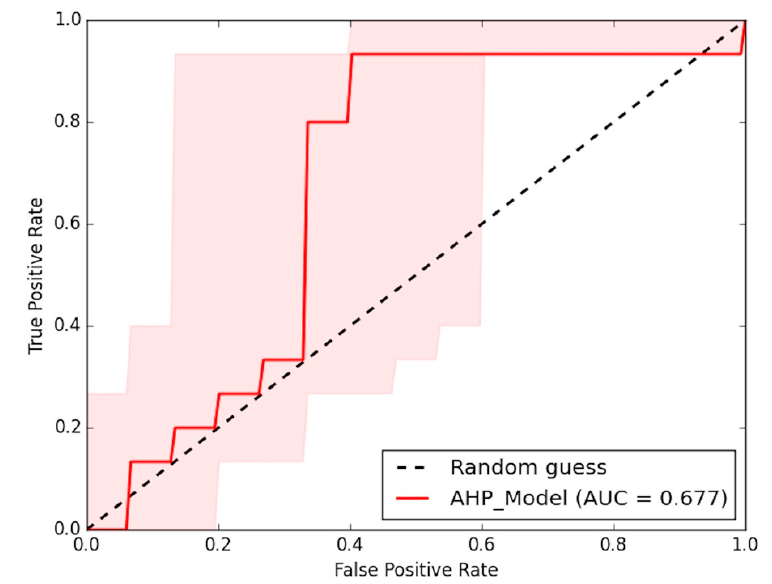
Figure 12. Receiver Operating Characteristic (ROC) curve for groundwater potential map valida- tion.